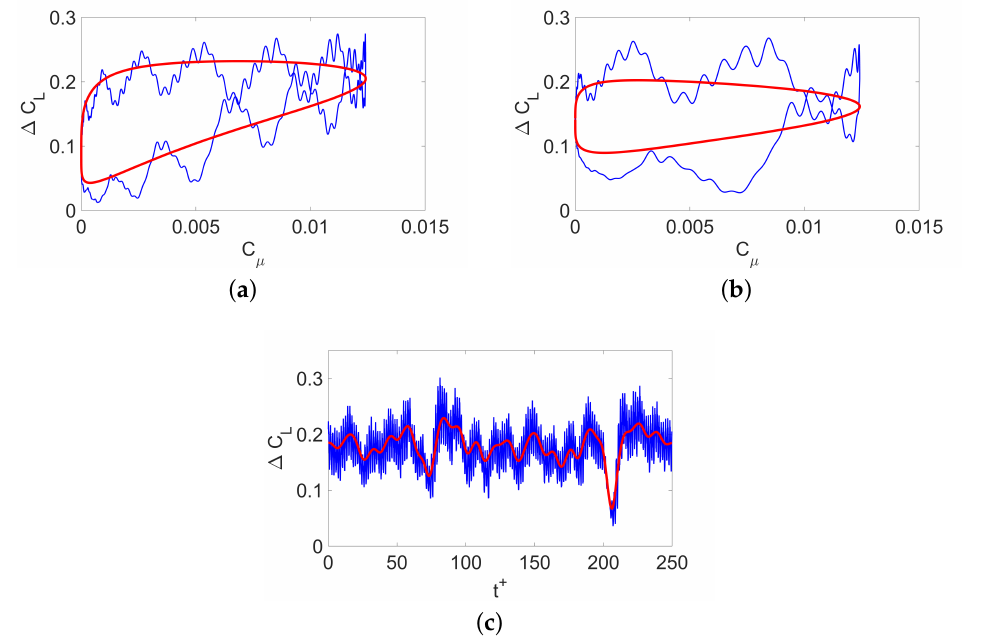
Figure 7. The comparison between the Wiener model (red line) and experimental data (blue line). ( a ) k = 0.128, ( b ) k = 0.25 and ( c )